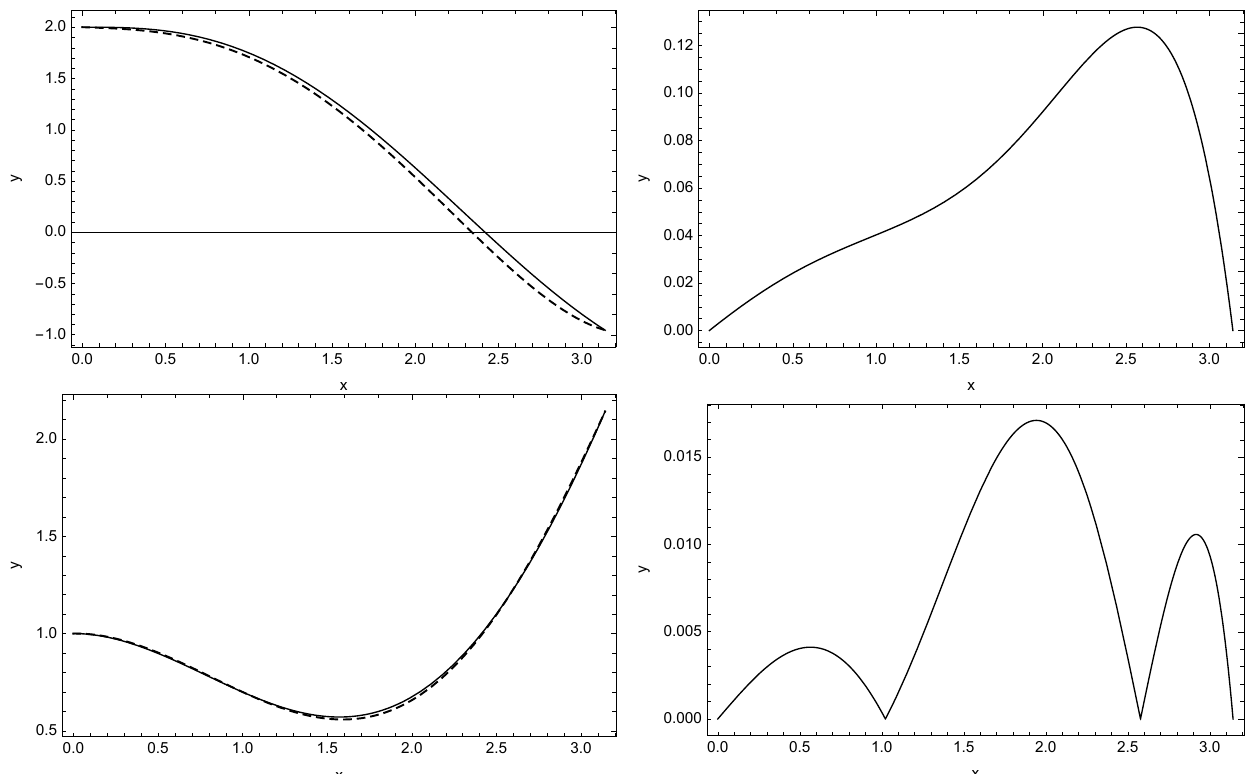
Figure 6. Plots of the solutions of problem (26) and (27): exact ones y 1 and y 2 —solid lines, approxi- mate ones y 1,6 and y 2,6 —dashed lines, together with the plots of absolute errors ∆